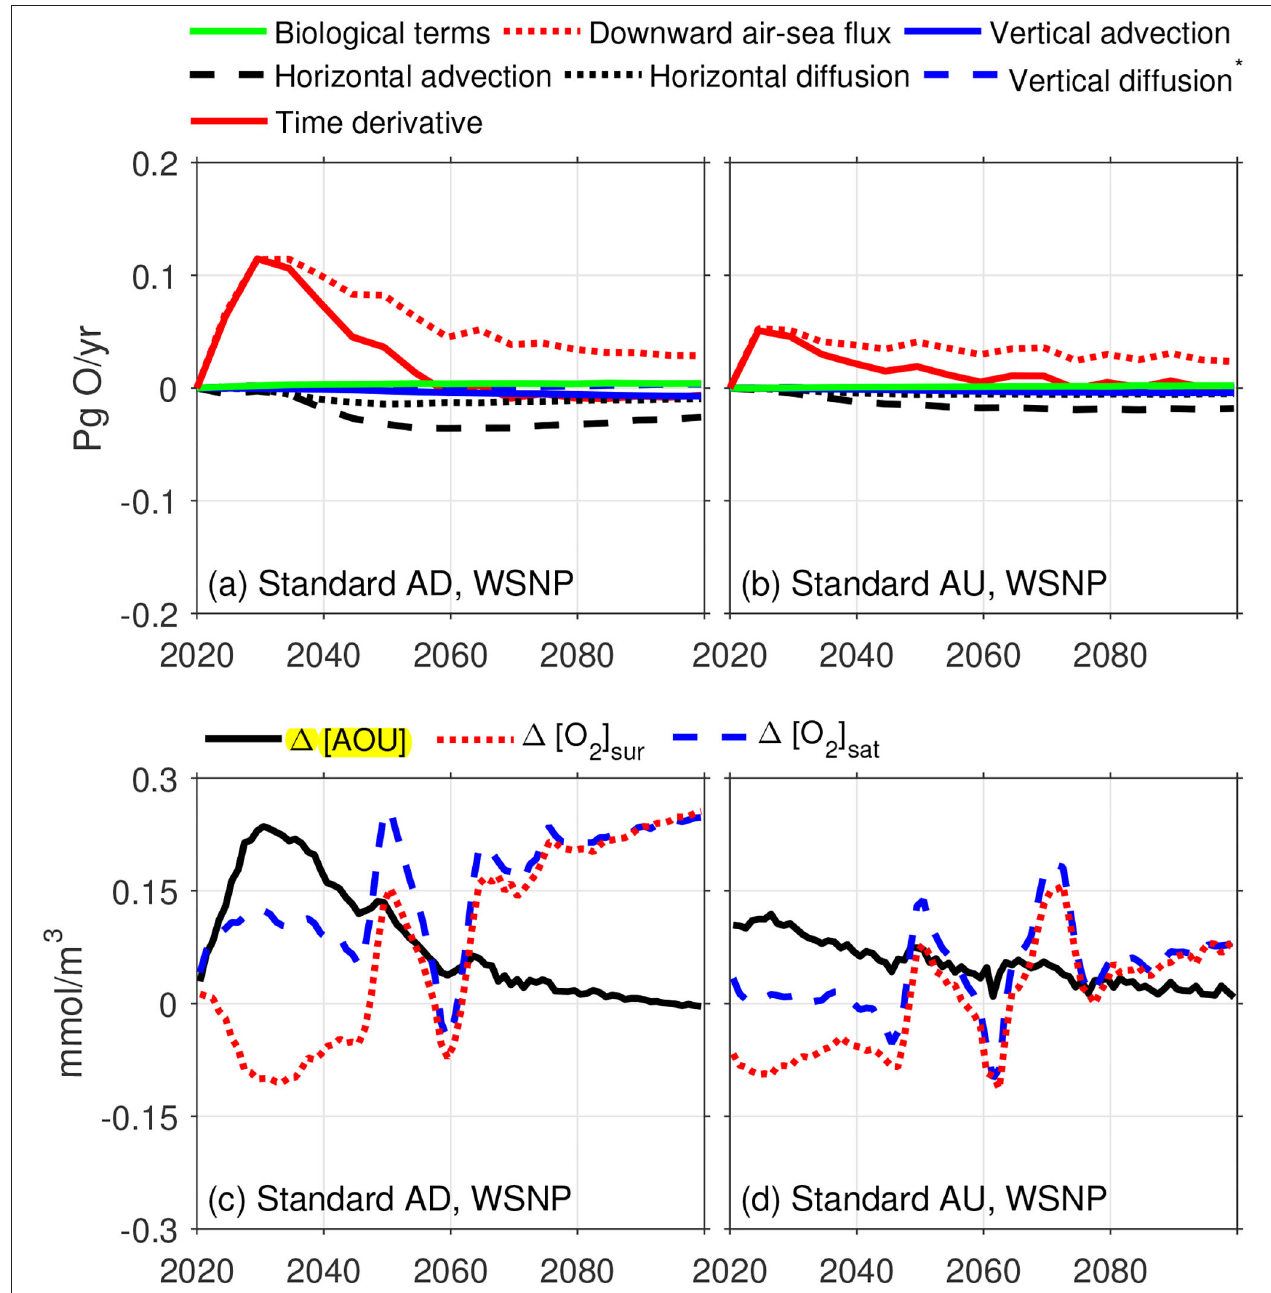
FIGURE 7 | Time series of (a) AD and (b) AU-induced anomalies of oxygen budget terms integrated within the 0–960 m range of the WSNP. The time derivative (red solid) is the sum of the biological terms (green solid), air-sea exchange (red dotted), water mass advection (blue solid for vertical; black dash for horizontal) and diffusion (blue dash for vertical; black dotted for horizontal). To understand air-sea oxygen change, we also give (c) AD and (d) AU-induced temporal variations of apparent oxygen utilization (AOU) at the ocean surface (black solid lines). AOU = [O2] sat -[O2] sur , where [O2] sat is the oxygen saturation (blue dash) and [O2] sur is the actual oxygen content (red